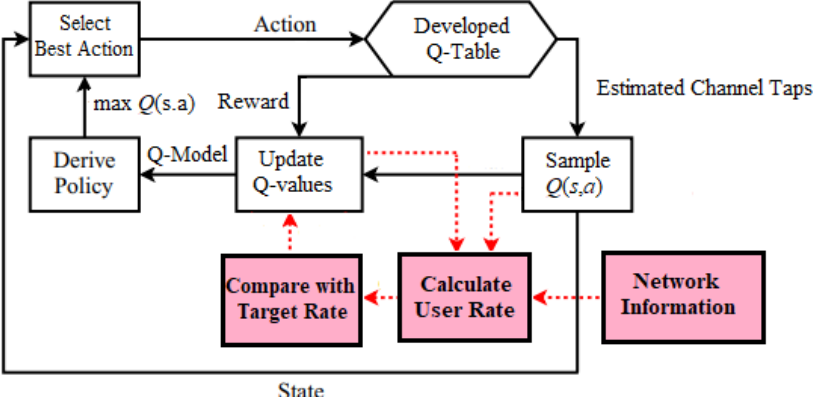
Figure 3. The architecture of the proposed Channel prediction scheme based developed Q-Learning algorithm.